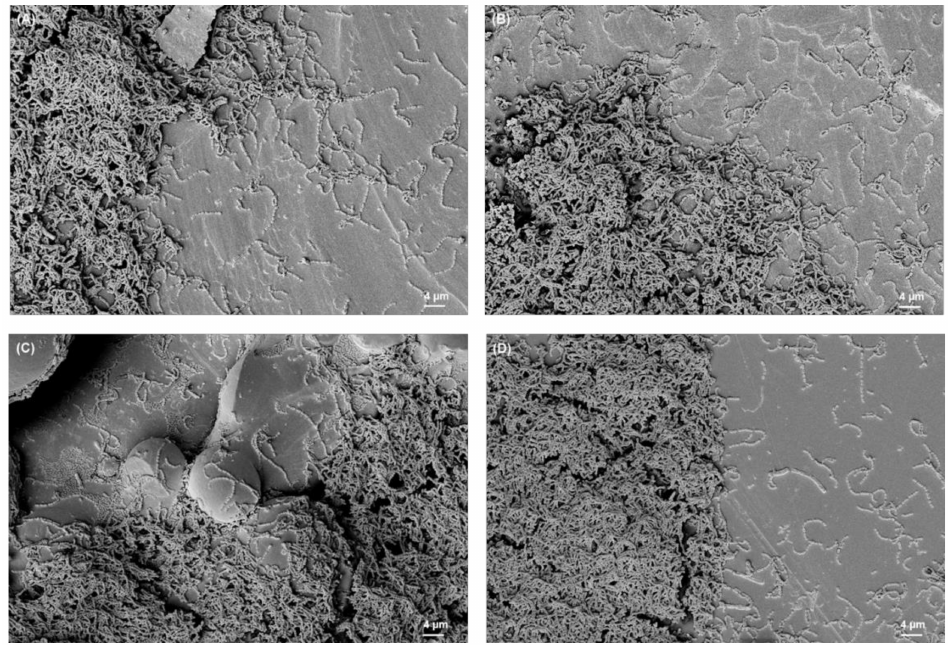
Figure 4. S. mutans biofilm on ( A ) Ti grade 23, ( B ) Ti grade 2, ( C ) Ti grade 5, ( D ) Ti grade 5 polished. All images were recorded at high voltage of 5 kV, magnification = 1.18 KX with scale bars = 4 µ